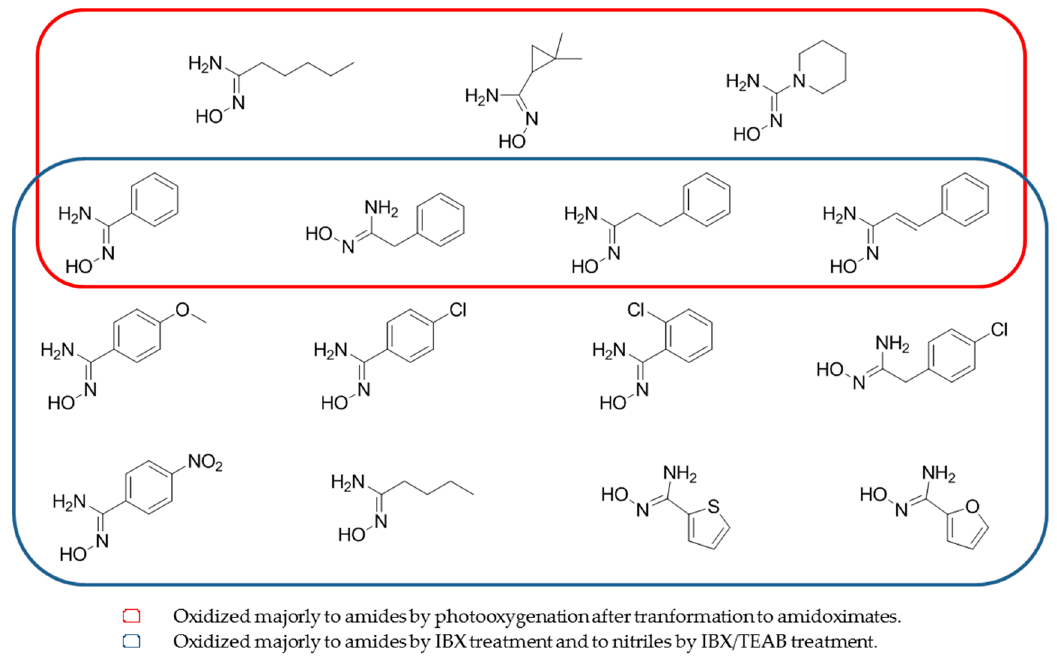
Figure 8. Structures of amidoximes able to be oxidized after photoxygenation or by treatment 2-iodobenzoic acid or IBX/tetraethylammonium bromide.